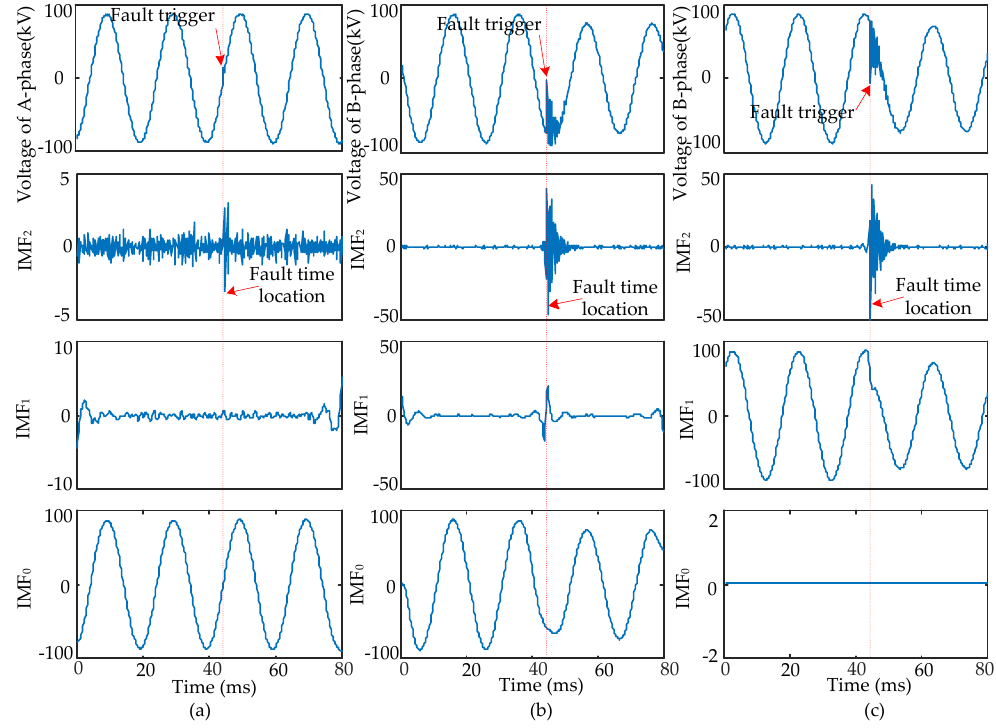
Figure 14. Actual BCG fault signal’s modes extracted by the EWT are shown as follows: ( a ) A-phase voltage and its IMFs; ( b ) B-phase voltage and its IMFs; ( c ) C-phase voltage and its IMFs.